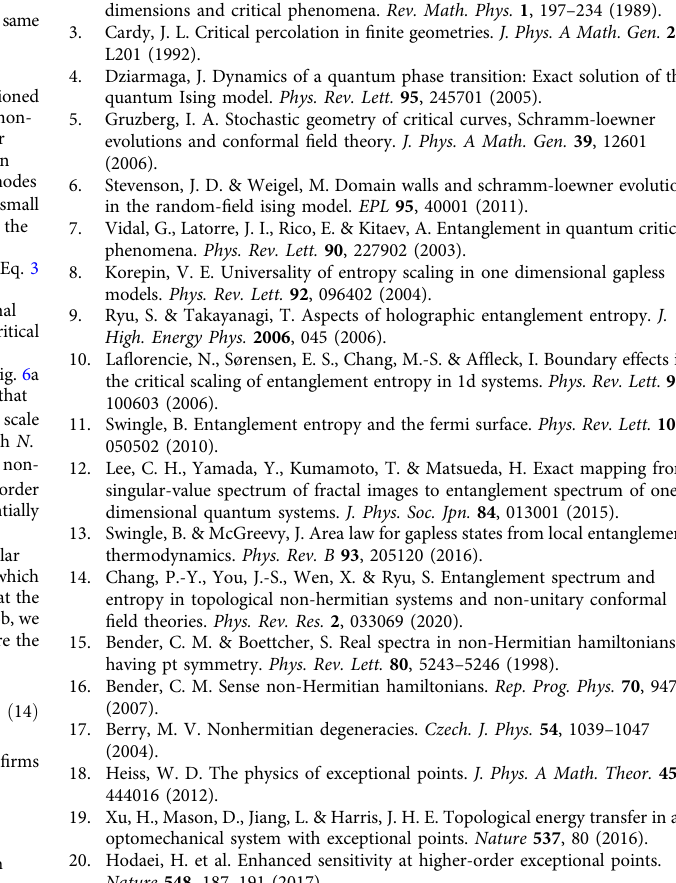
− κ δ = − δ a b is obtained from Eq. (14) with a b varying from 0.1